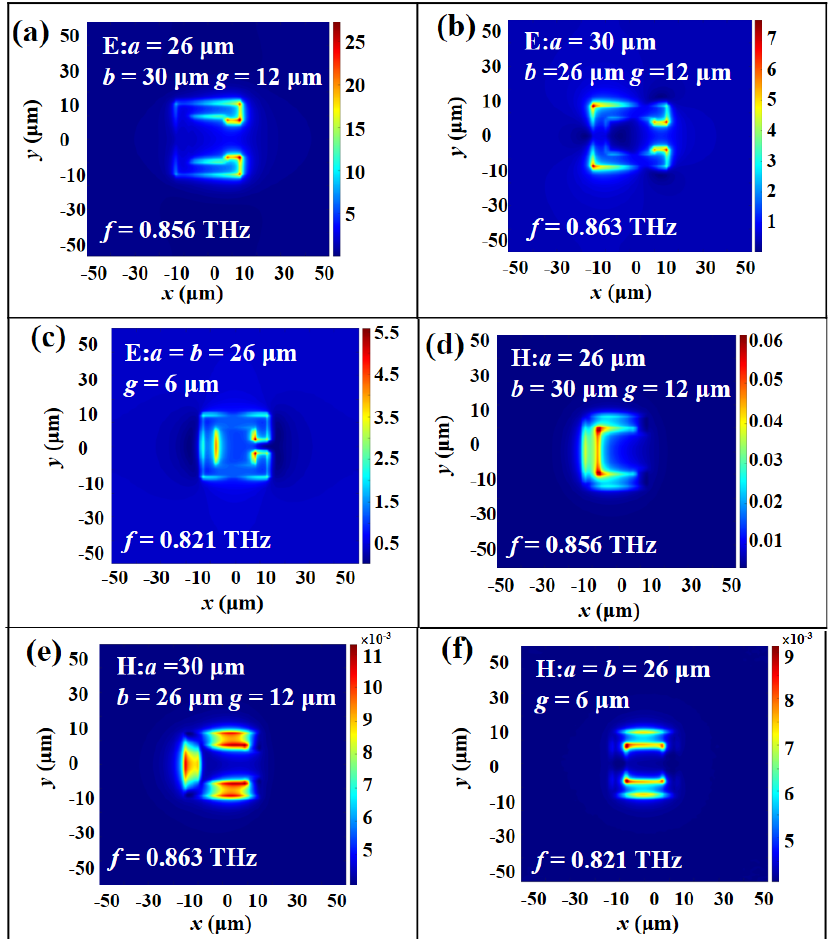
Figure 3. ( a – c ) E– and ( d – f ) H–field distributions of MTM at the condition of a , b , and g values in TM